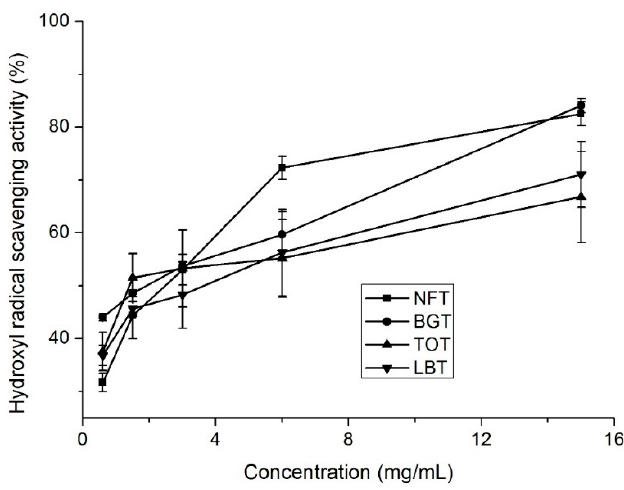
Figure 3. Hydroxyl radical scavenging activity of different tea samples. NFT, novel fermented tea; BGT, Boseong green tea; TOT, Tieguanyin oolong tea; LBT, Lipton black tea.